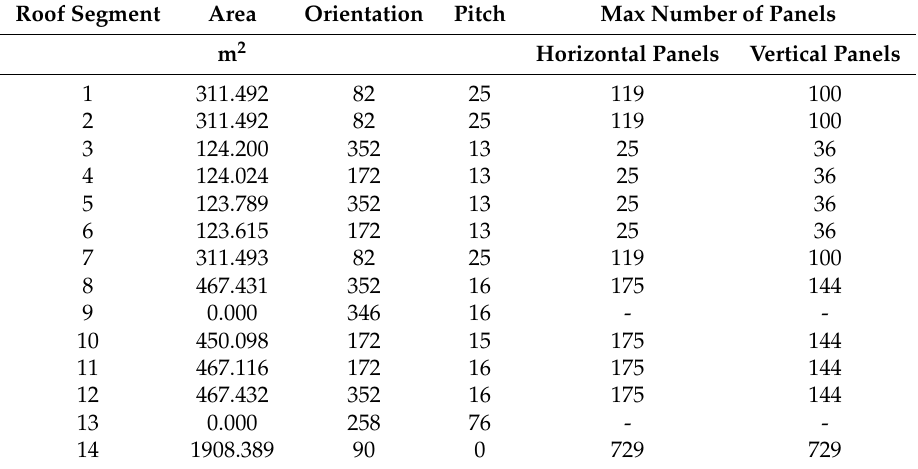
Table 2. Roof Segment layout showing the roof parameters and the maximum number of vertical and horizontal